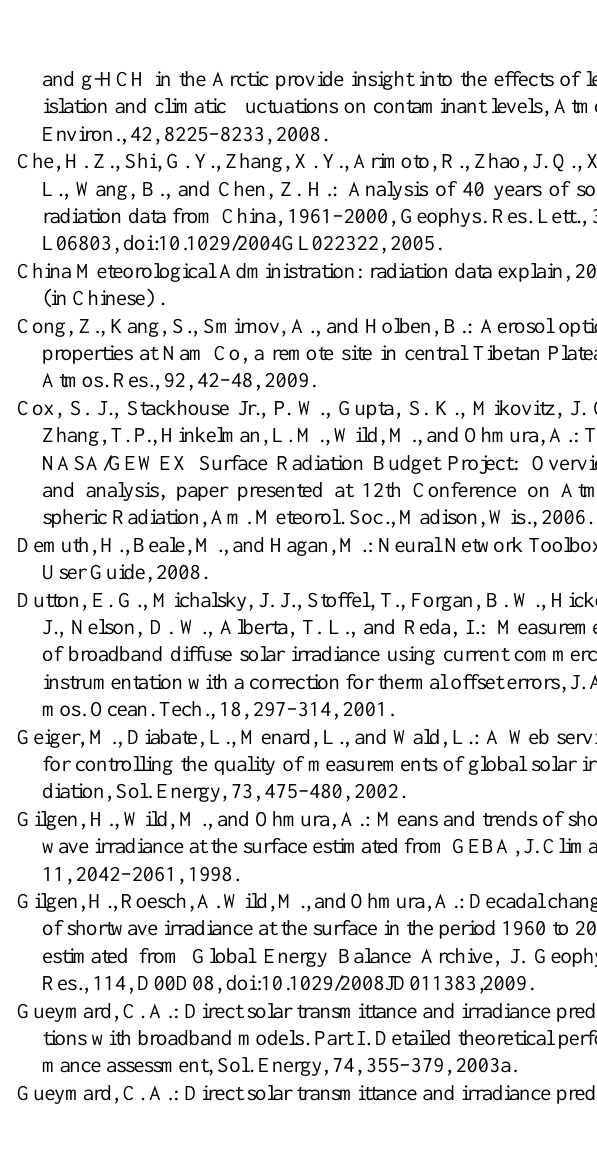
Fig. 11. The differences between the default case and the four extreme cases for the time series between 1961 and 2006 averaged over all CMA stations. The five cases are explained in the